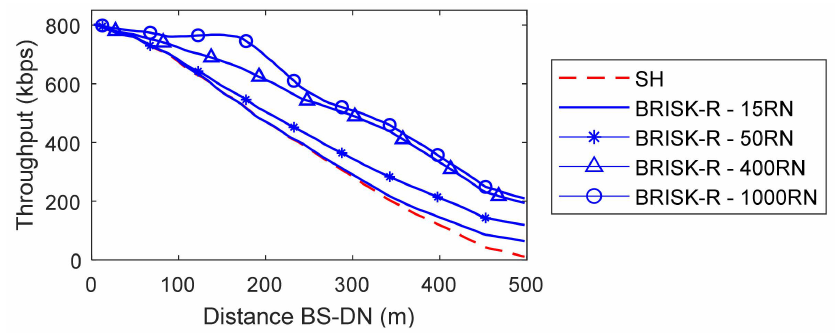
Figure 6. Throughput comparison (for di ff erent UE densities) as a function of the distance between DN and BS—web tra ffi c & homogeneous scenario.